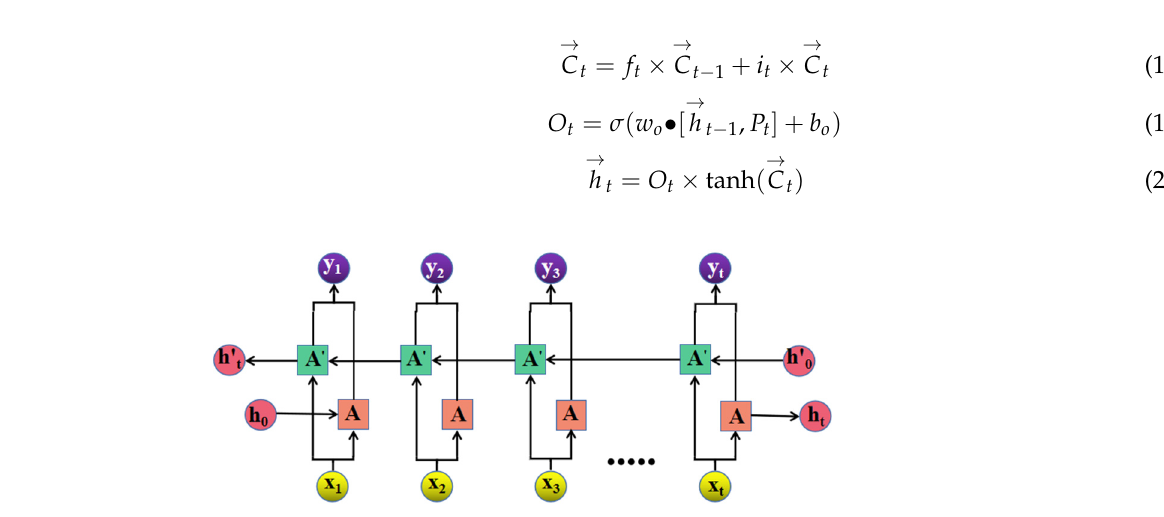
Figure 7. Bi-LSTM structure.